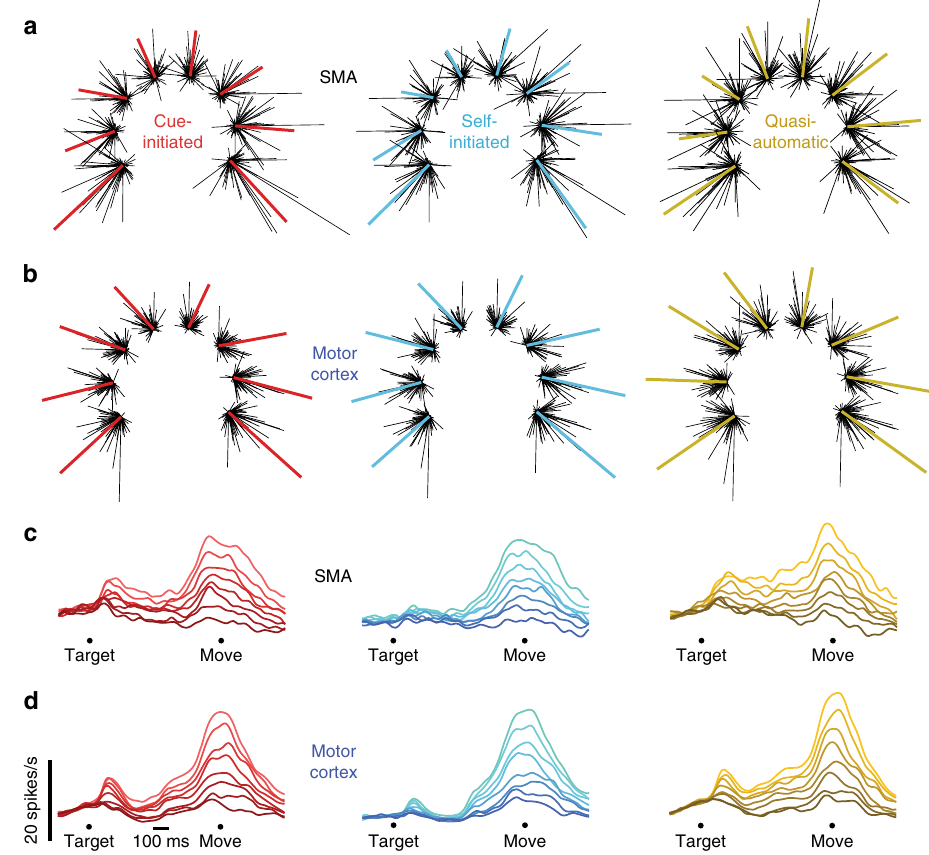
Fig. 3 Population vectors and population PSTHs for monkey Ba. a SMA population vectors for each of the three contexts. Each cluster of lines corresponds to one of the eight reach directions. The length of each black line indicates the fi ring rate of one neuron for that direction and context, and points in that neuron ’ s preferred direction. Colored traces plot (on a different scale) the sum of those vectors. For each neuron, the preferred direction was computed based on fi ring rates across all directions and contexts. b Motor cortex population vectors. Scaling is arbitrary and differs between the two brain areas, as they had different average fi ring rates (see main text). c SMA population PSTHs for the three contexts. Shading is ordered from most-preferred direction (lightest) to least-preferred (darkest) within each context. d Motor cortex population